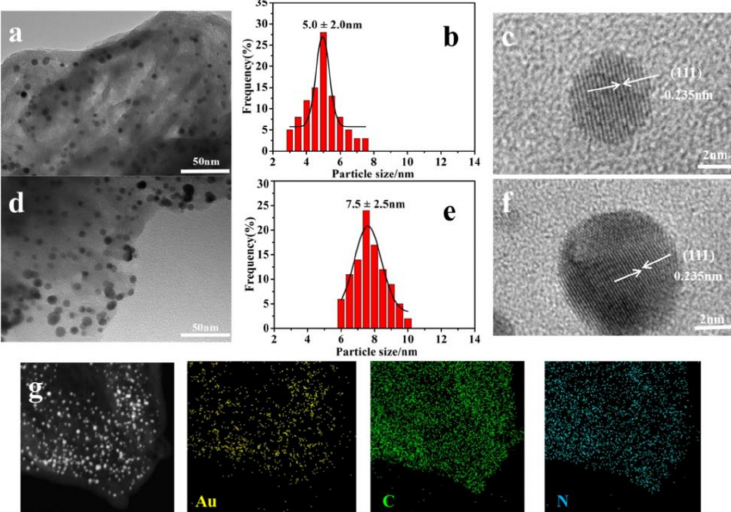
Figure 1. ( a ) TEM image; ( b ) particle size distribution and ( c ) HRTEM photograph of Au/C 3 N 4 -500(N 2 ); ( d ) TEM image; ( e ) particle size distribution and ( f ) HRTEM image of Au/C 3 N 4 -500(Air); ( g ) EDS mapping of Au/C 3 N 4 -500(N 2 ) (scale bar 100 nm). The elemental mappings show the distribution of Au, C, and N elements.